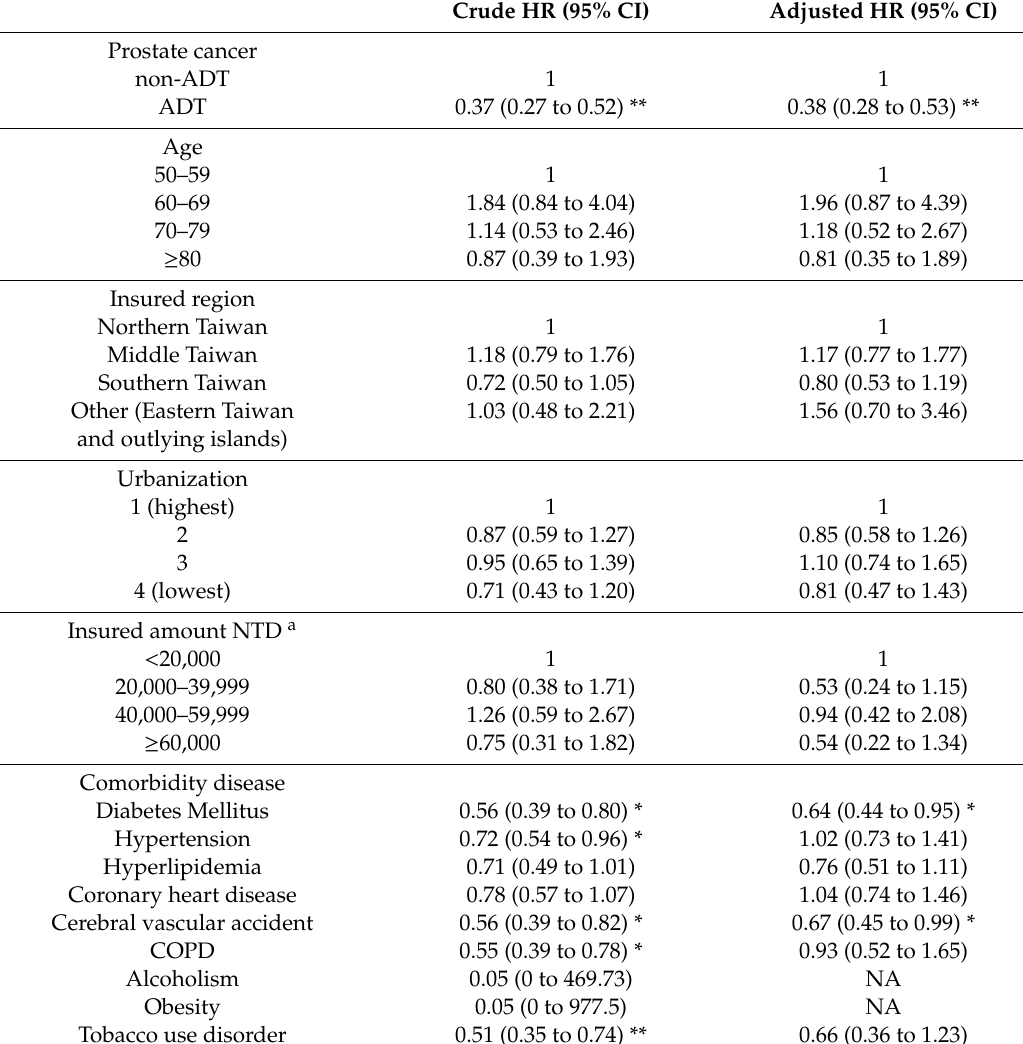
Table 3. Independent predictors of renal calculi analyzed by Cox regression